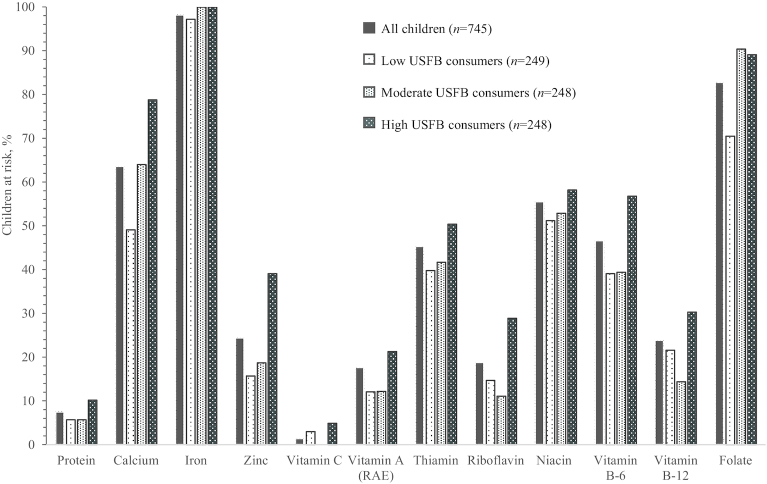
Proportion of Kathmandu Valley children aged 12–23 mo at risk of inadequate nutrient intakes, by tertiles of USFB consumption. Includes estimated nutrient intakes from breast milk. Vitamin C intake for middle USFB consumption tertile could not be normalized. RAE, retinol activity equivalents; USFB, unhealthy snack food and beverage.